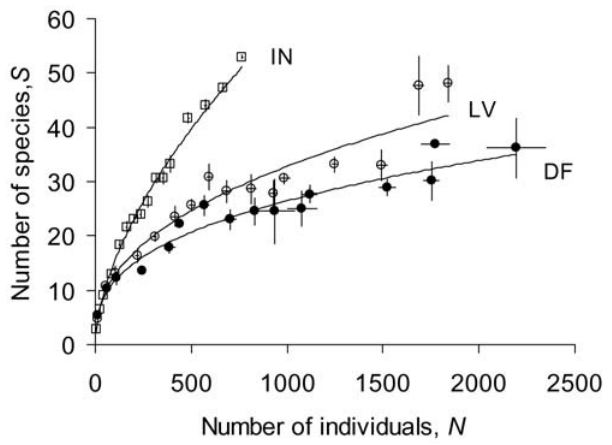
Figure 5. Simulated steady-state relationships of species to individuals. Each point shows the mean 6 s.e. of the three replicate communities in Fig. 4, and regression lines on the means are the power functions for intrinsically neutral (top) Lotka-Volterra (middle) and dominant-fugitive (lower) scenarios.